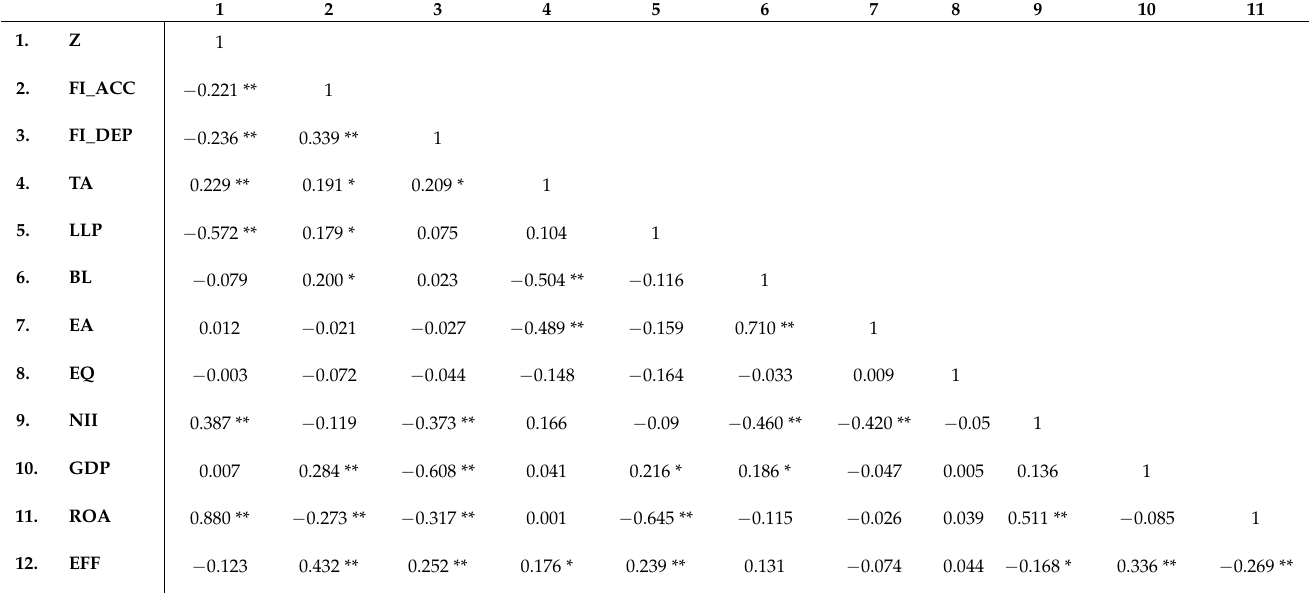
Table 4. Pearson’s correlation matrix for all variables.